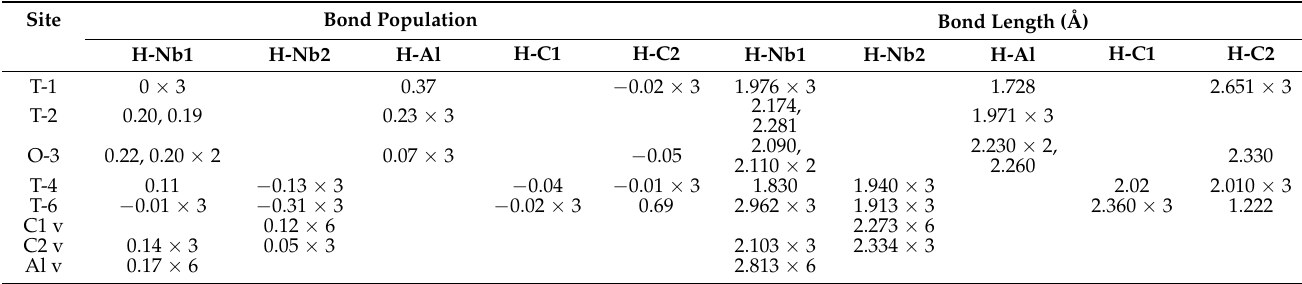
Table 4. Bond populations and bond lengths for H- Nb(1, 2), Al, or C(1, 2)